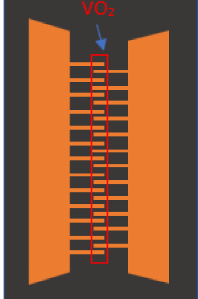
Figure 12. Signal line of CPW switches consist of 24 parallel structure.